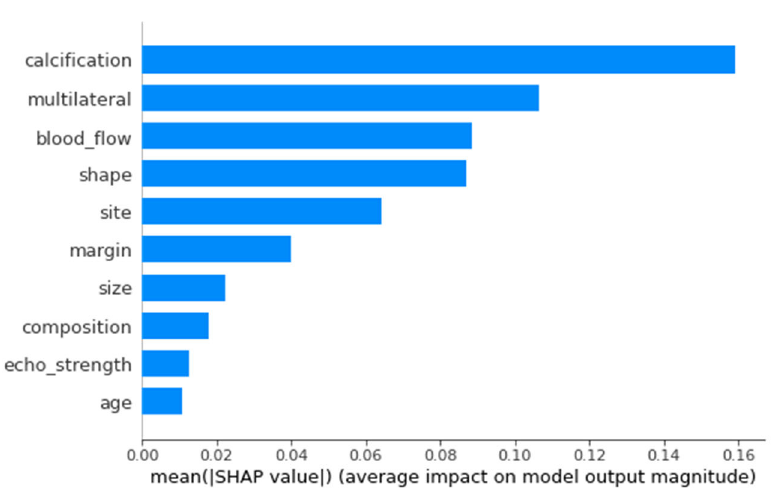
Figure 6. Mean SHAP values for the features of the second model.